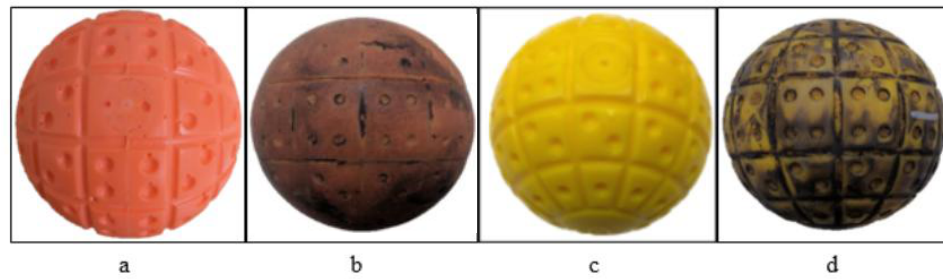
Figure 1. Ball Types: ( a ) Orange Ball; ( b ) EOL Orange Ball; ( c ) Yellow Ball; ( d ) EOL Yellow